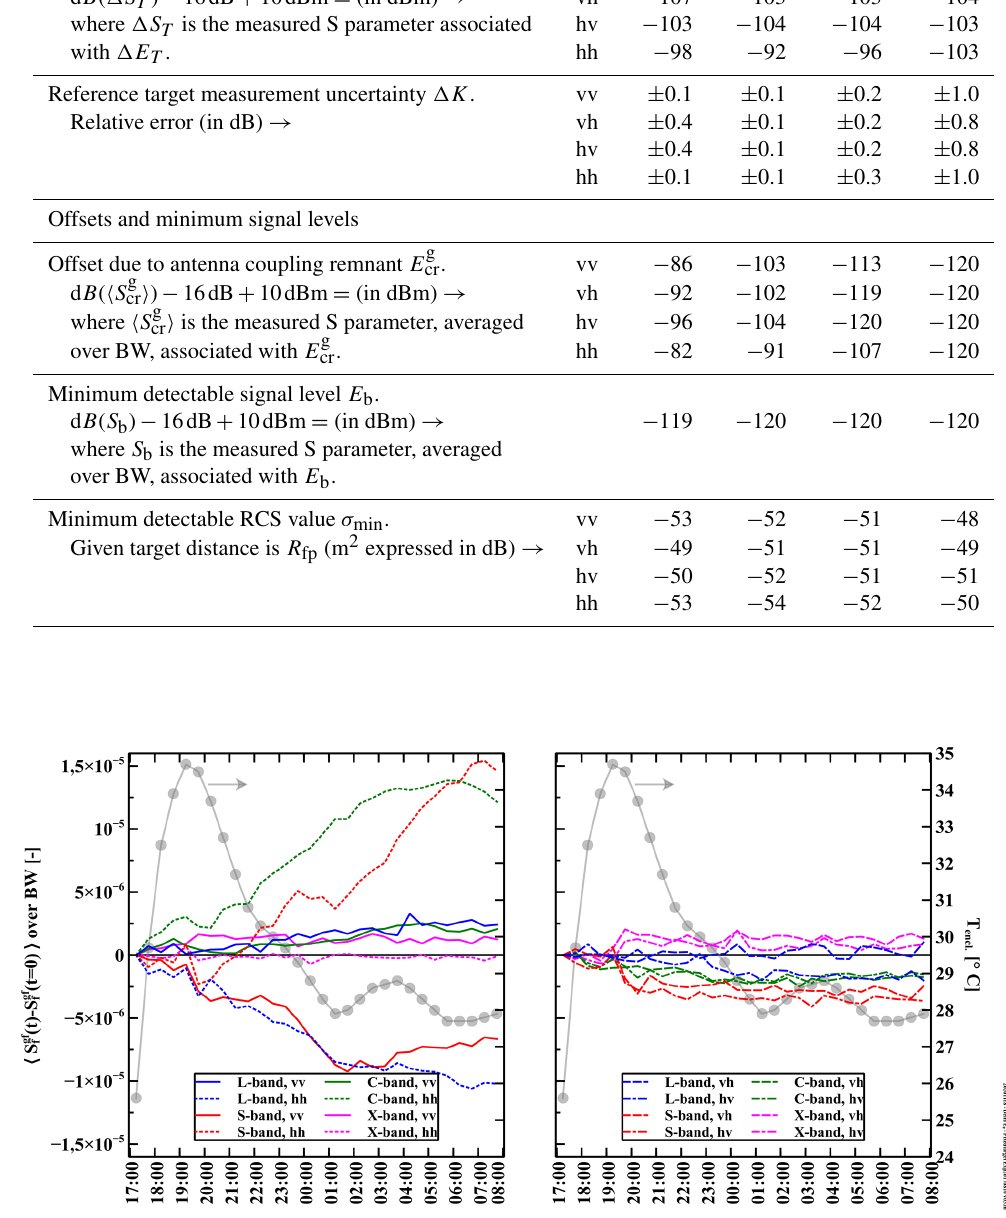
Table E1. Summary of systematic uncertainties, offsets, and minimum signal levels. Concerning (cid:49)E T , E receiver power levels derived from measured S parameters which, in their turn, are associated with (cid:49)E T , E g cr , and E b . With (cid:49)K and σ min actual values are shown.